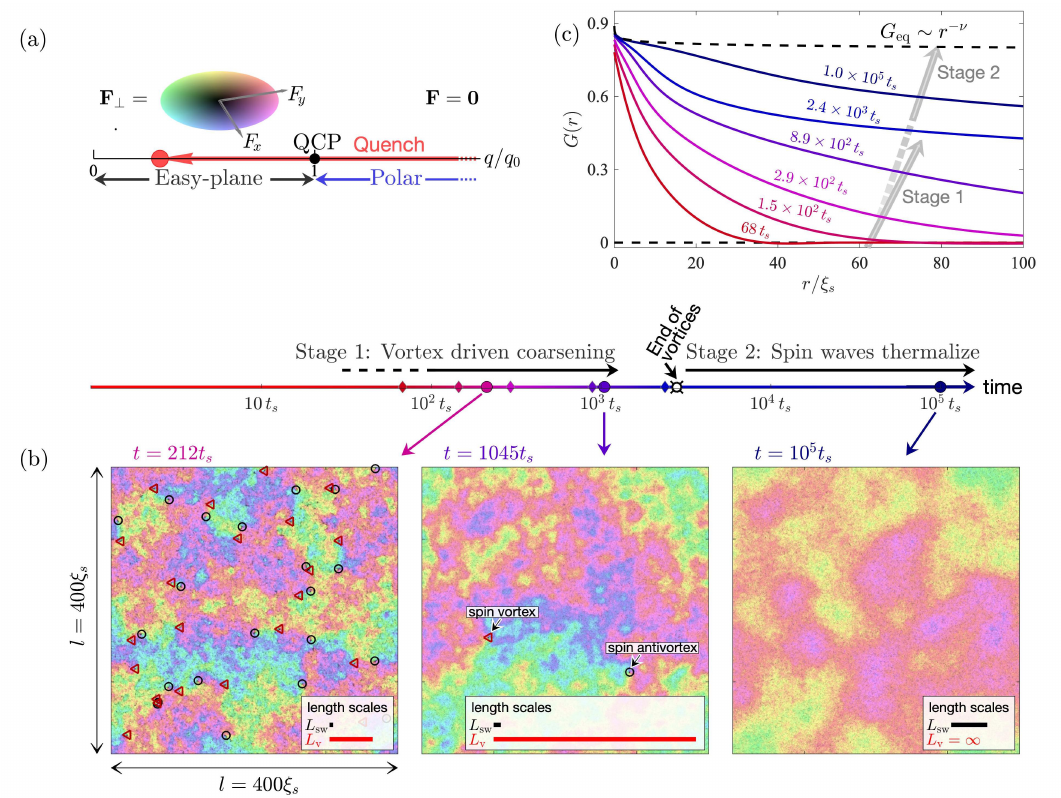
Figure 1: (a) A spin-1 ferromagnetic condensate is unmagnetised (“polar”) for q > q 0 and magnetises in the transverse plane (“easy-plane”) for 0 < q < q . The point 0 q = q is a quantum critical point (QCP). We explore the ordering of transverse spin 0 following a quench from q (cid:29) q to q = 0.3 q . (b) Coarsening of transverse spin 0 0 domains [ colormap shown in (a) ] . This is associated with collisions between trans- verse spin vortices (red triangles) and antivortices (black circles), which can then mutually annihilate, resulting in a growing intervortex spacing L (red bar). A sec- v ond length scale L giving the thermal wavelength of spin waves grows much more sw slowly (black bar), such that the transverse spin remains out of equilibrium long after all transverse spin vortices have annihilated. The central time axis quantifies the first stage of vortex driven coarsening, the time of last vortex annihilation, and the subse- quent stage of spin wave thermalisation. (c) Spatial correlations of transverse spin at different times, showing that long after all vortices have annihilated the correlations still decay more rapidly than the equilibrium prediction (upper black dashed